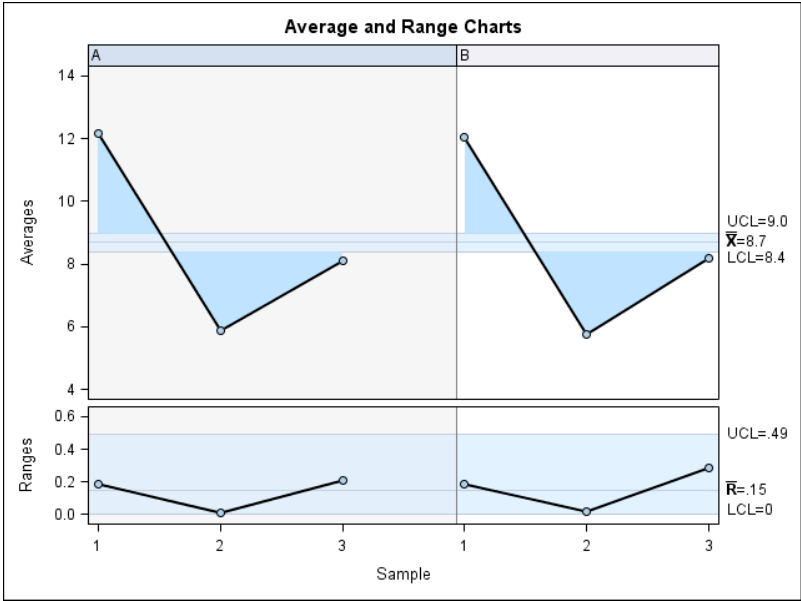
Figure 10. Charts of the average of two measurements of the cement area remaining after lingual multibracket therapy debonding (1), the cement area remaining after cement clearance (2), and the enamel area removed after cement clearance (3) performed by each operator (average) and the differences of the two measurements of the three area parameters determined by each operator (ranges).